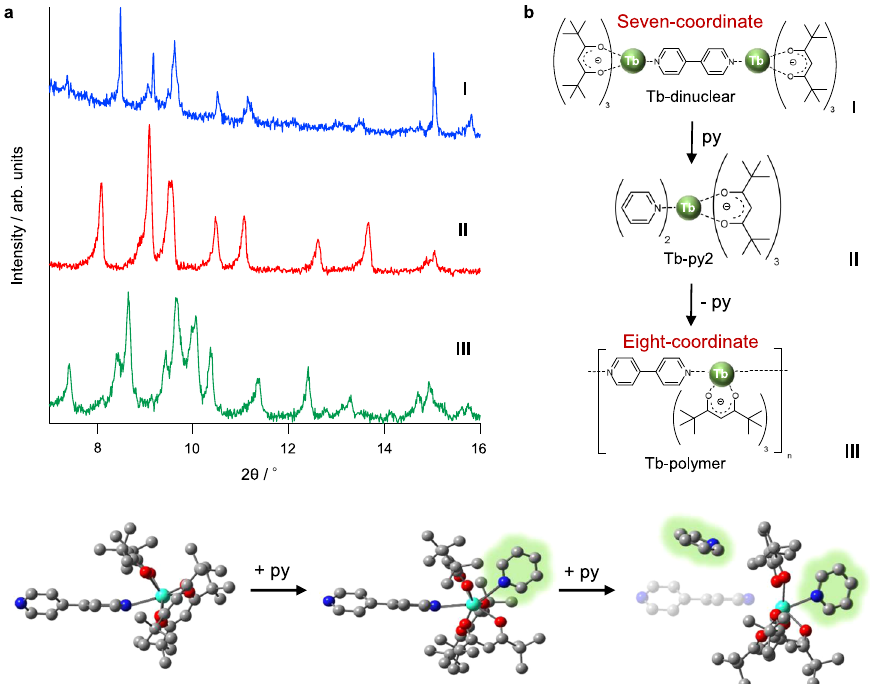
Fig. 3 Structural polymerization. a Powder X-ray diffraction patterns of the crystal sample at different steps. I: initial state (blue line: dinuclear structure); II: addition of pyridine (py) vapor (red line: conversion to [Tb(tmh) 3 (py) 2 ] with uncoordinated 4,4 ’ -bpy); III: elimination of py under vacuum (green line: transformation to coordination polymer). The third step includes the by-product [Tb(tmh) 3 (py) 1 ] 56 . b Illustration of the transformation. c Proposed structural transformation with py insertion. One Tb(tmh) 3 center of the dinuclear structure and hydrogen atoms are omitted for clarity. Gray spheres represent carbon; red spheres, oxygen; blue spheres, nitrogen and green spheres, terbium. Py molecules are highlighted in green. Tb, terbium; tmh, 2,2,6,6- tetramethyl-3,5-heptanedionato; 4,4 ′ -bpy, 4,4 ′ -bipyridine; py,